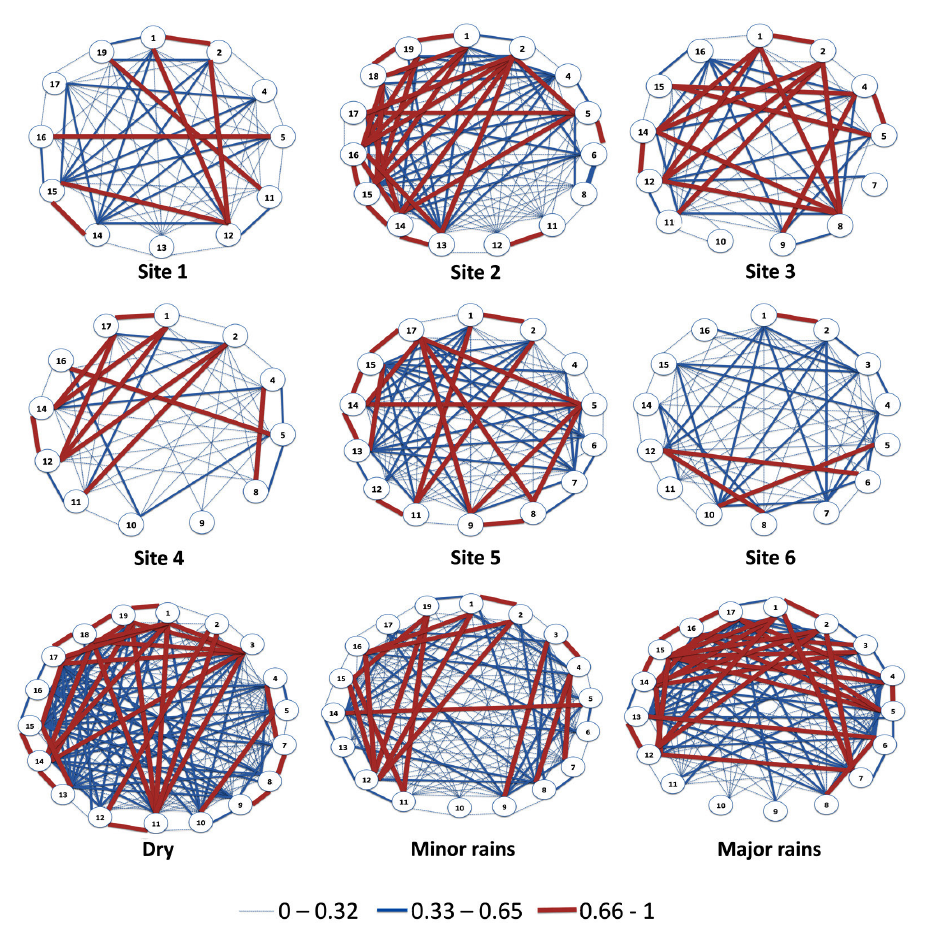
= 0.17). Axes 1 and 2 explained 71% of the data variation. Ten anurans species (52.6%) did not show tendencies to be grouped in trophic guilds: C. raniformis, B. pugnax, L. insularum, L. fragilis, L. fuscus, L. poecilochilus, Phyllomedusa venusta, Pseudopaludicola pusilla, Scarthyla vigilans and Trachycepallus typhonius . These species showed different patterns in their feeding habits and, therefore, it was not possible to locate them in a defined trophic guild (Fig. 3).